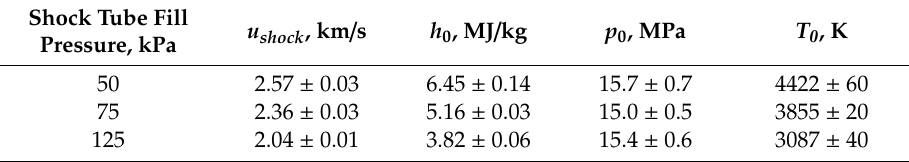
Table 1. Shock tube and nozzle reservoir flow